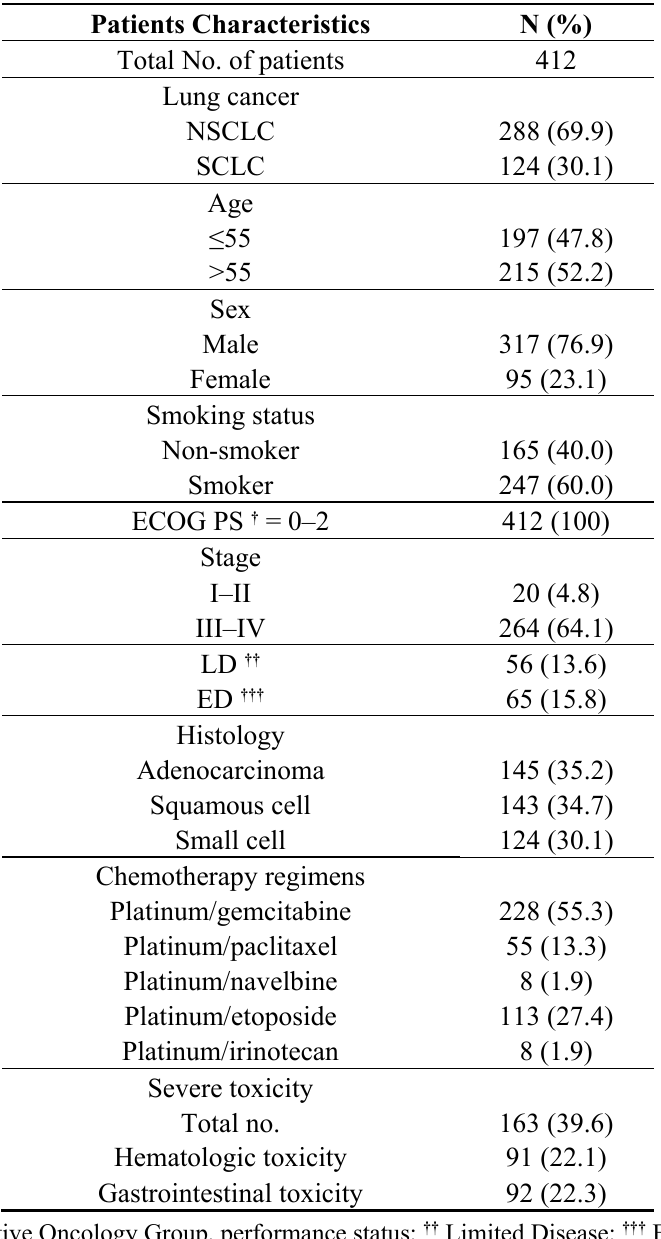
Table 4. Clinical characteristic of lung cancer